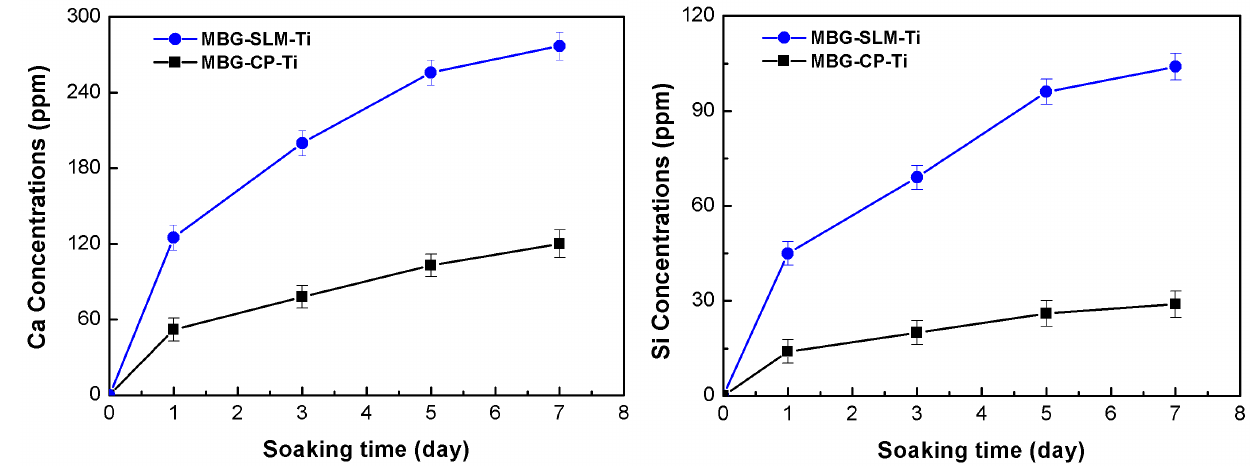
Figure 7. Release profiles of Ca and Si ions from the MBG-SLM-Ti and MBG-CP-Ti after soaking in the cell culture solution for 1, 3, 5 and 7 days.